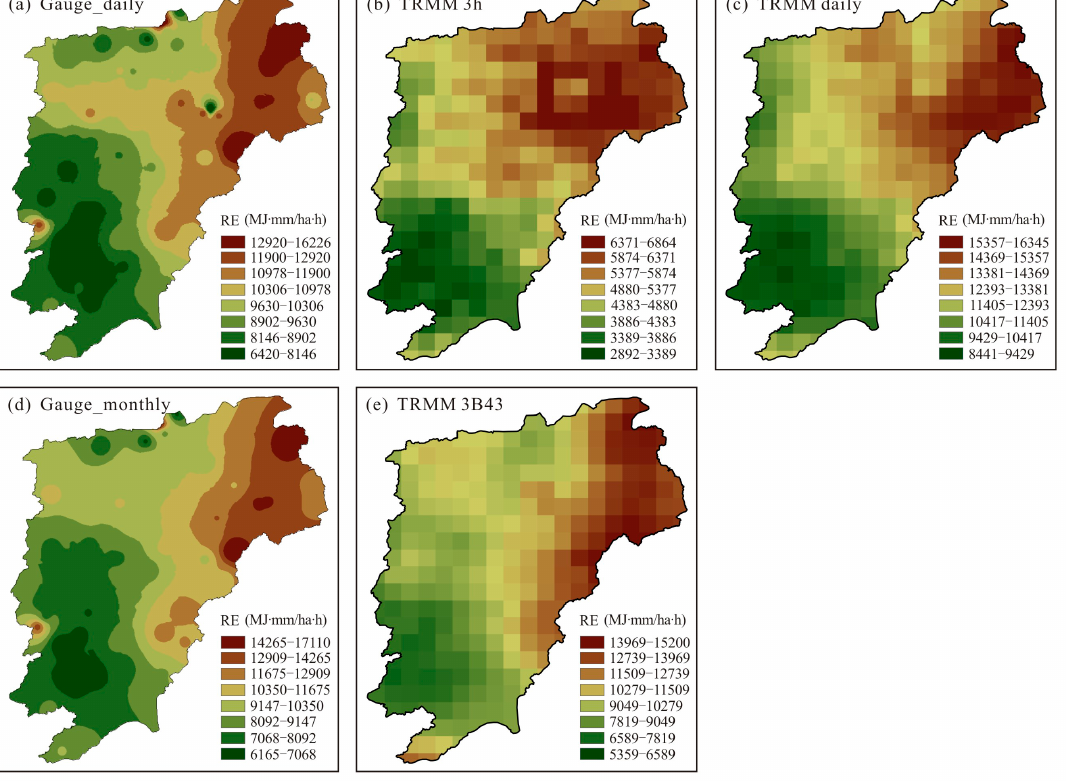
Figure 10. Scatter plots of annual rainfall erosivity at rain gauges against their nearest satellite pixel. Figure 11 shows the spatial distributions of four evaluating indices values (R, ME, RMSE, and BIAS) of annual RE estimation from TRMM rainfall products for every rain station. The statistical distributions of stations in different categories of evaluation indices were summarized in Table 3. The annual RE from the TRMM daily and 3B43 data correlated well with that from the rain gauges data, and their R values exceeded 0.8 at 45 (59.2%) and 46 (60.5%) of the 76 stations, respectively. The number of stations with R > 0.8 was only 20 (26.3%) for the TRMM 3-hourly data. However, all three